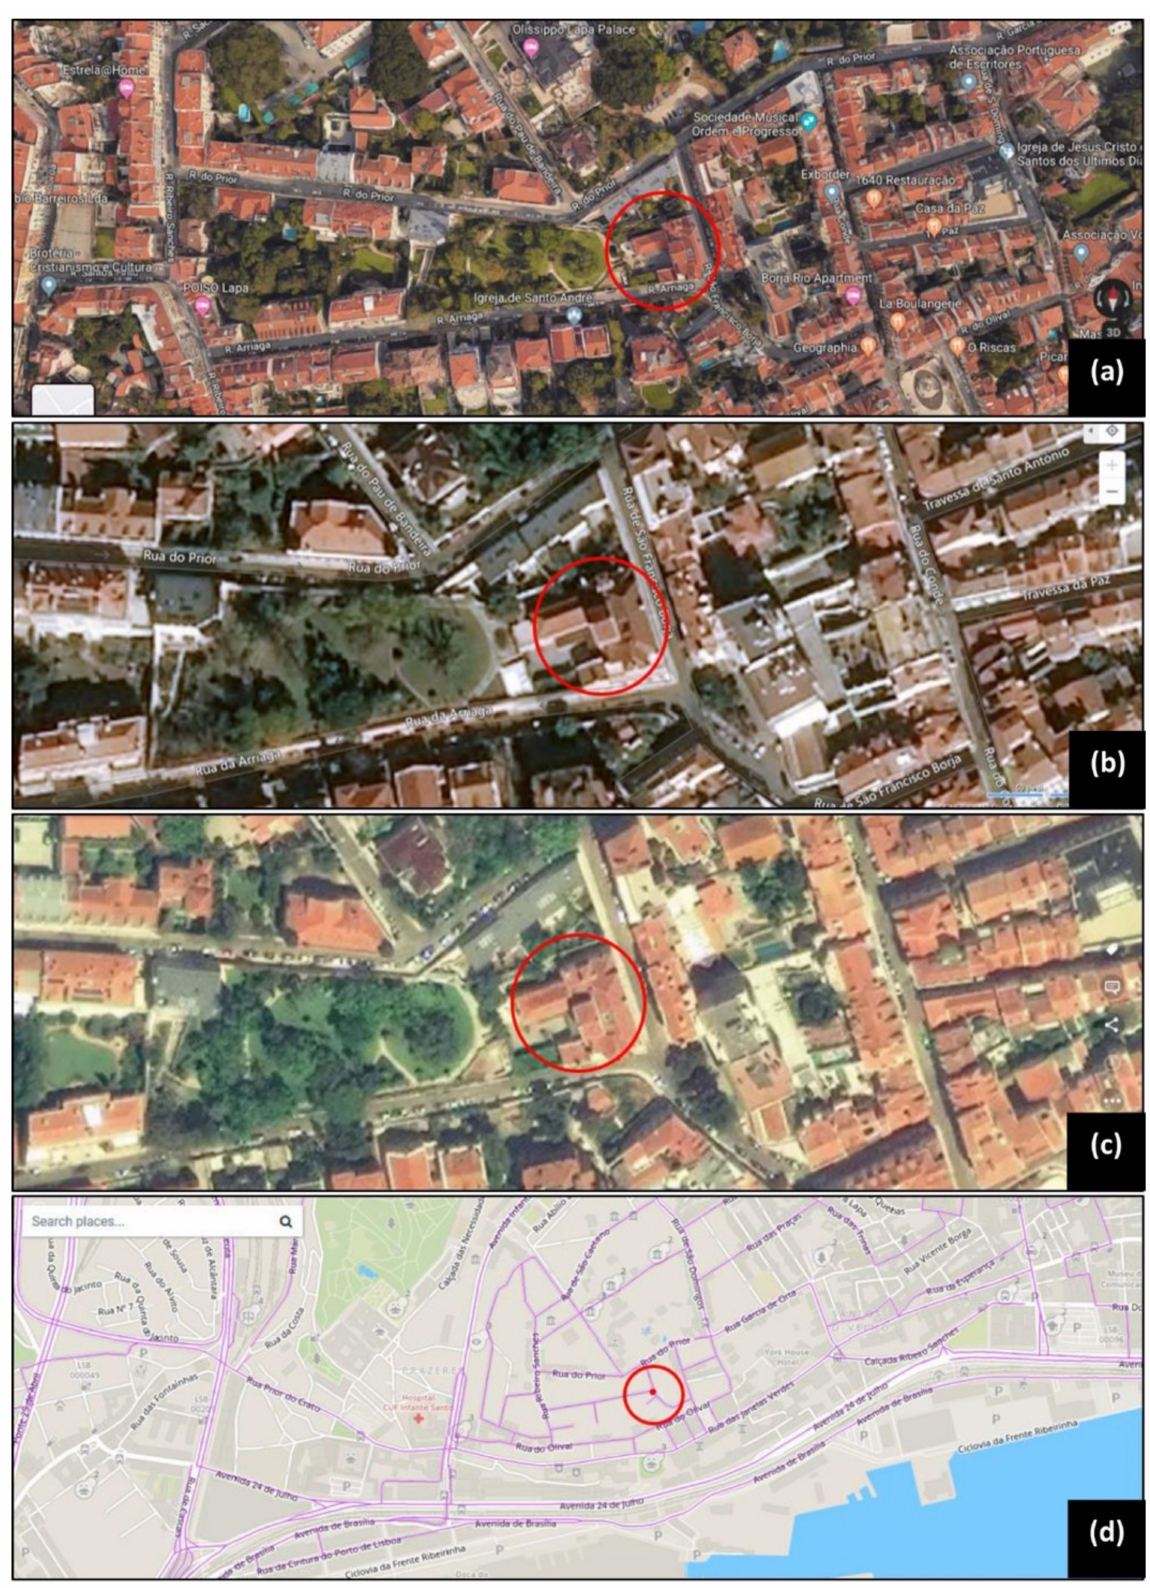
Figure 1. Comparison of the satellite images for evaluating plan regularity by using different web platforms: ( a ) Google Maps, ( b ) Bing Maps, ( c ) Mapillary, ( d )